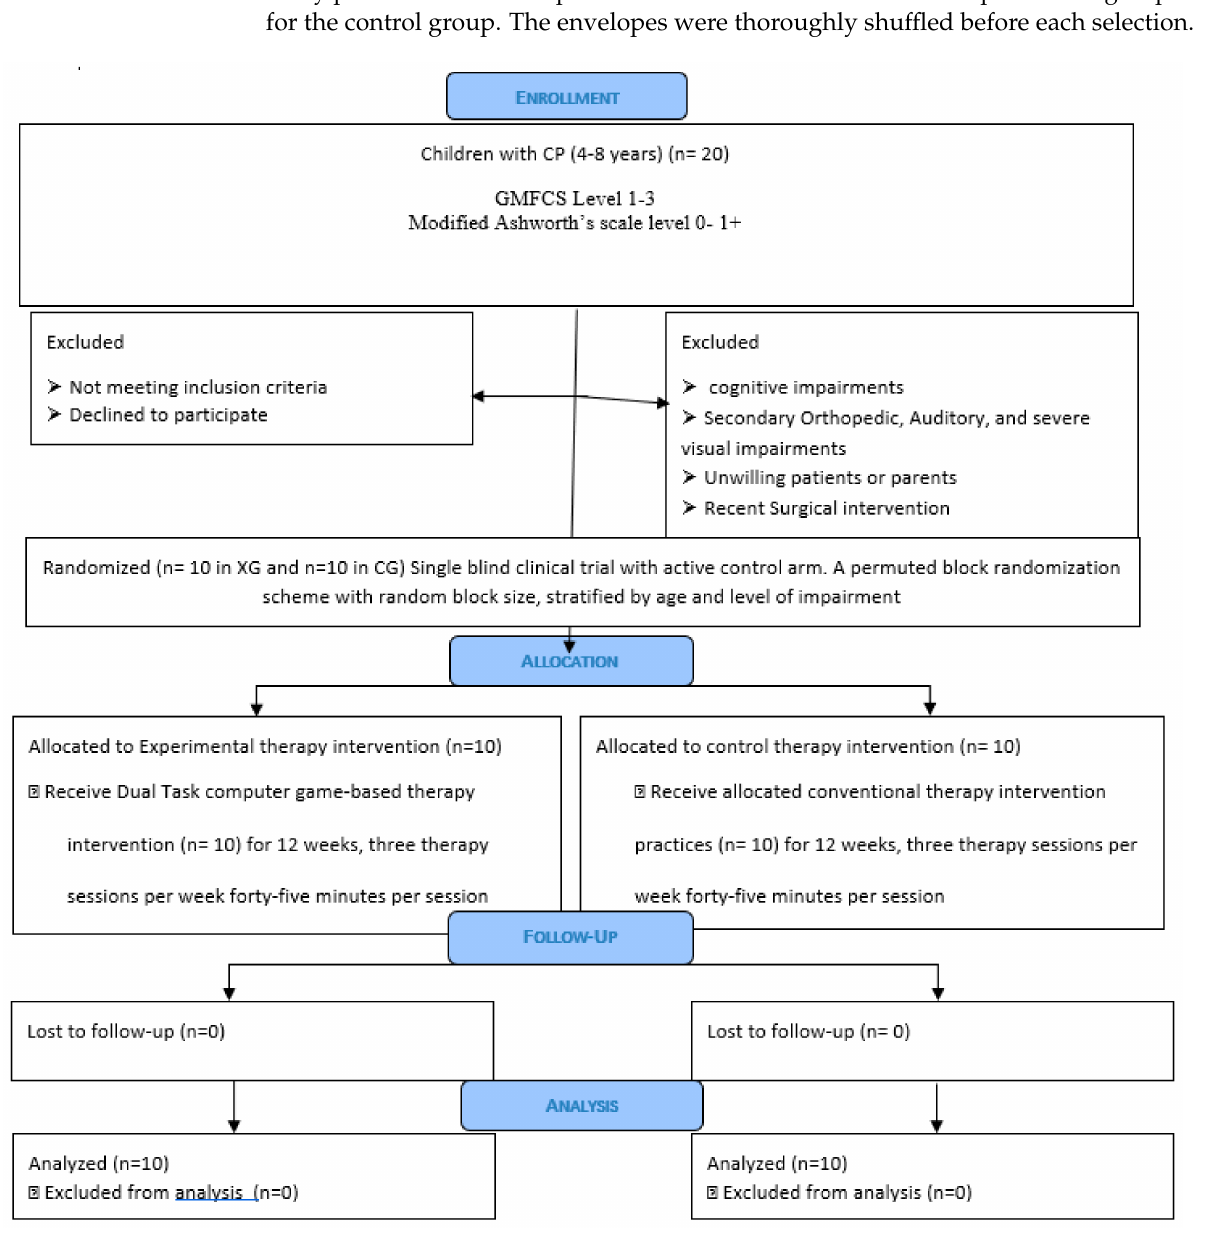
Figure 1. CONSORT Flow